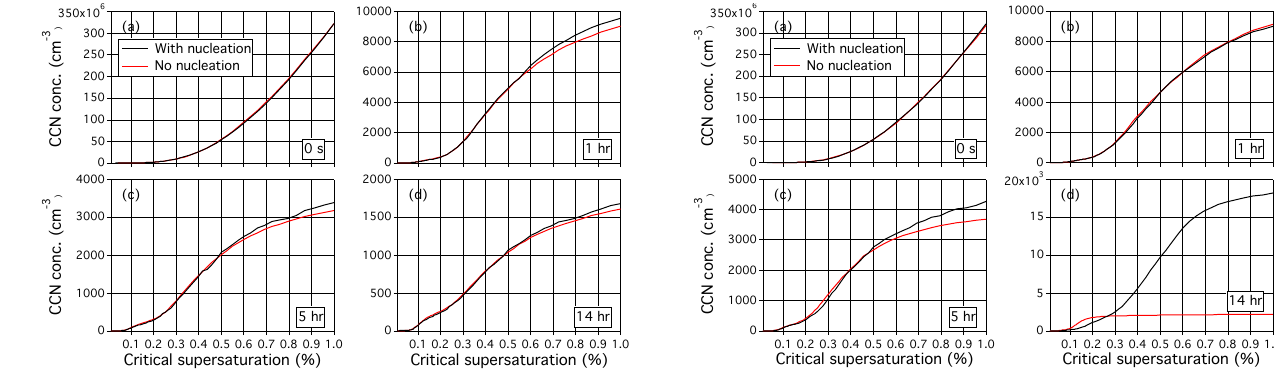
Figure A3. CCN number concentrations as the function of critical supersaturation at 0s, 1h, 5h and 14h for the base case, compar- ing the simulation with nucleation enabled to the simulation with nucleation disabled.